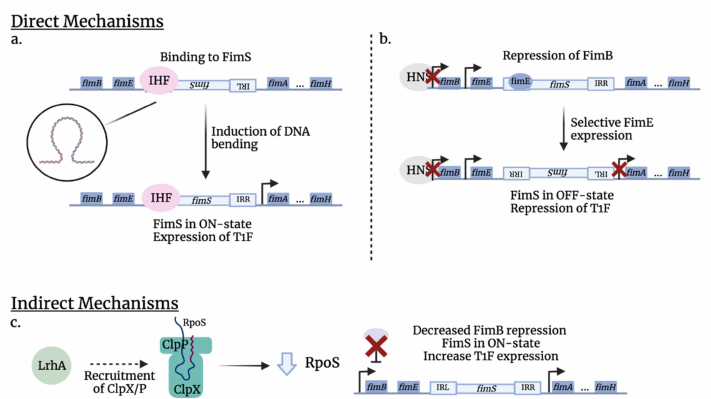
Figure 3. Mechanisms of action of stress regulators on type 1 fimbriae expression. ( a ) Regulators can bind directly to fimS to influence phase variation. For example, IHF binds to regions of fimS to induce a sharp DNA bend that facilitates the recombination of the fim switch. In nutrient-deprived environments, such as when bacteria enter the stationary phase, IHF expression will be induced, increasing phase variation, and influencing type 1 fimbriae expression. ( b ) Regulators can block recombinase expression to influence fimS phase variation. In the case of H-NS, the regulator can bind to the FimB promoter to block its expression, resulting in more FimE production. Since FimE facilitates phase variation of fimS in the OFF-state, type 1 fimbriae will be repressed. This is a simplified model of regulation by H-NS as the latter binds to both FimB and FimE promoters. ( c ) Other regulators may be indirectly linked to stress by influencing direct stress regulators. Although LrhA can act directly on type 1 fimbriae and flagellar gene expression, it is indirectly linked to stress via the RpoS network. LrhA recruits ClpX/P protease complex through an unknown mechanism (dotted arrow), leading to reduced RpoS production. As a result, FimB repression decreases and more fimS is found in the ON-state, which increases type 1 fimbriae